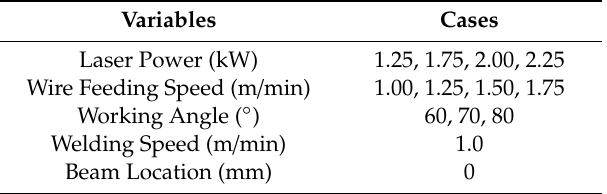
Table 3. Conditions of laser welding for Invar with 1.5 mm thickness.